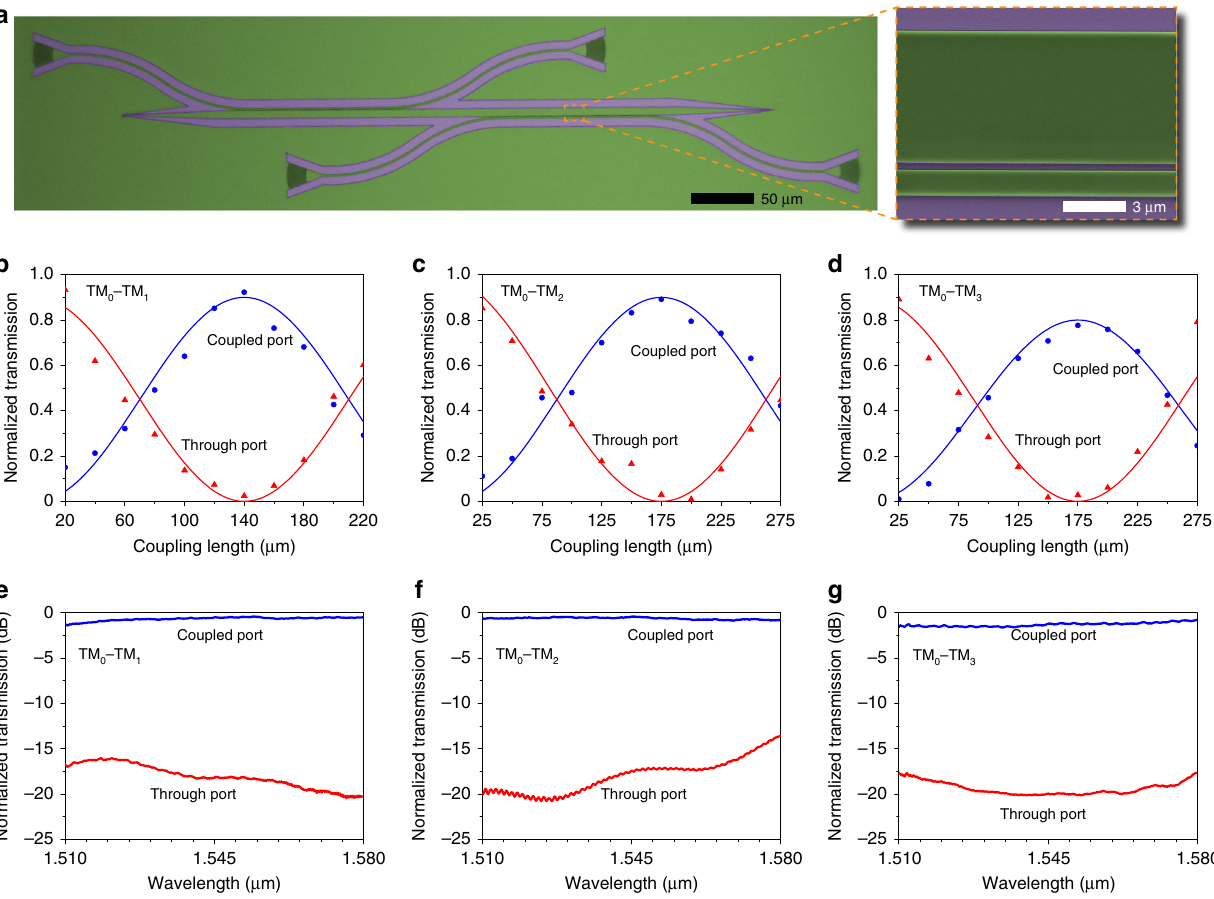
Fig. 4 Microscopic images and measured properties of BIC multimode directional couplers. a Optical microscope (left) and scanning electron microscope (right) images of the fabricated multimode directional coupler. The close-up (right) shows the details of the coupling region. b – d Normalized transmission at the wavelength of 1.55 μ m of the coupled (blue dots) and through (red triangles) ports of the TM 0 ‒ TM 1 ( b ), TM 0 ‒ TM 2 ( c ), and TM 0 ‒ TM 3 ( d ) multimode directional couplers as a function of the coupling length. The solid lines are fi ts by using a sinusoidal function. e – g Normalized transmission spectra of the coupled and through ports of the TM 0 ‒ TM 1 ( e ), TM 0 ‒ TM 2 ( f ), and TM 0 ‒ TM 3 ( g ) multimode directional couplers with the respective coupling length of L 1 = 140, L 2 = 175, and L 3 = 175 μ